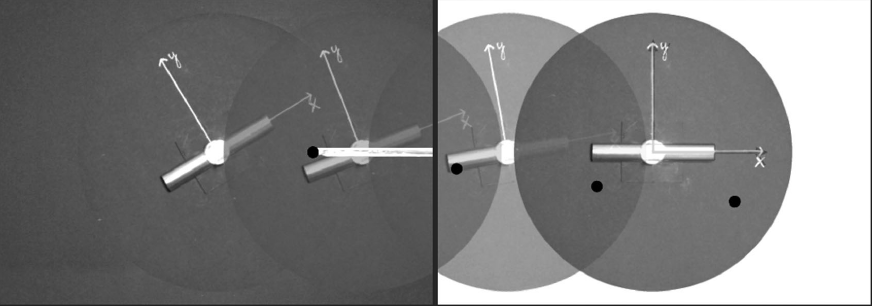
FIG. 4. Illustration of the animation as a series of still images captured at different points in time. The animation dynamically transforms the laboratory system to the coordinate system of the